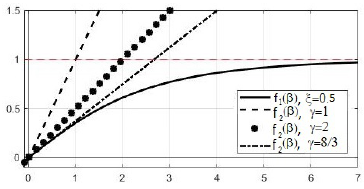
Figure 3. Graphics of the function f 1 ( β ) for ξ = 0 . 5 and function f 2 ( β ) for h = 0 . 02 and variuos γ . The root β 0 of Equation (2.8) does not exist.